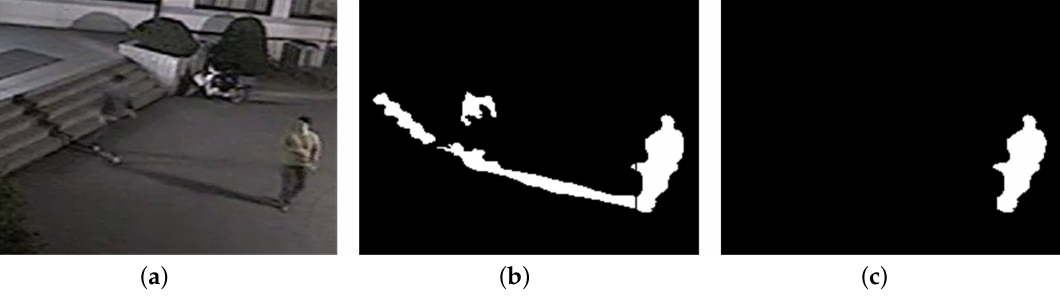
Figure 16. Shadow removal result 5 for a foreground object (240 × 180 pixels from sequence S2): ( a ) Foreground objects; ( b ) Partitioned objects ( c ) Foreground object after shadow